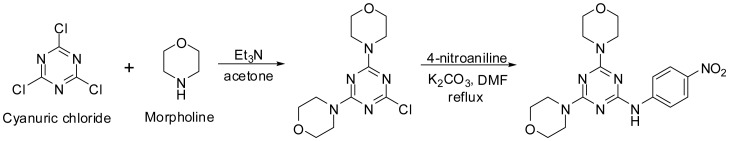
Brief scheme of the synthetic process of MHY1485.